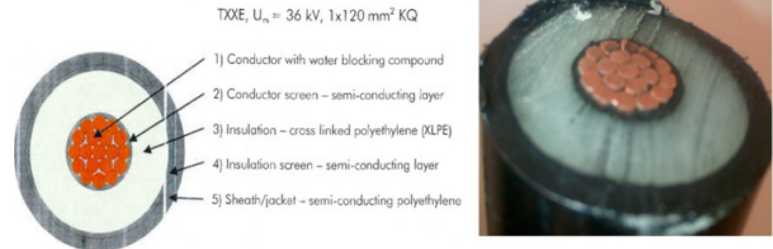
Figure 2. Structure of the cable phase ( left ); the photograph ( right ). Source: NEXANS. Table 1. Thermal and mechanical properties of cable components [8].